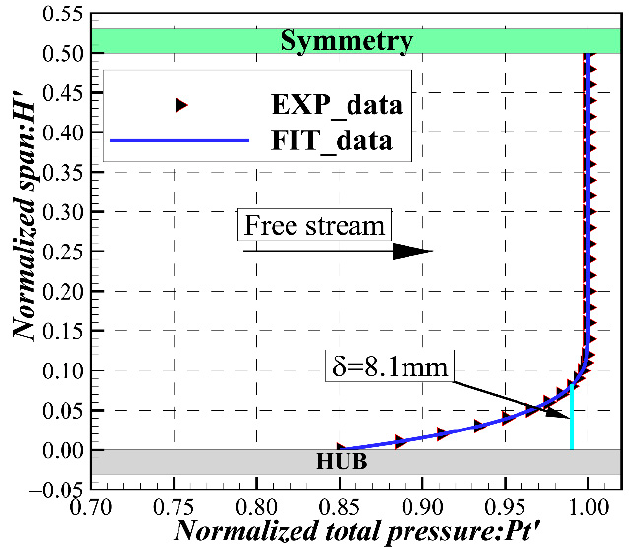
where H is the height of blade. During the operation of the simulation, the convergence criterion were as follows: the residual error was less than 10 − 5 without fluctuation, and the Mach number of the inlet section was within the range of 0.7 ± 0.001. For the present work, the solver invoked 22 CPUs (4.3-GHz processor) in parallel running for 30 h.